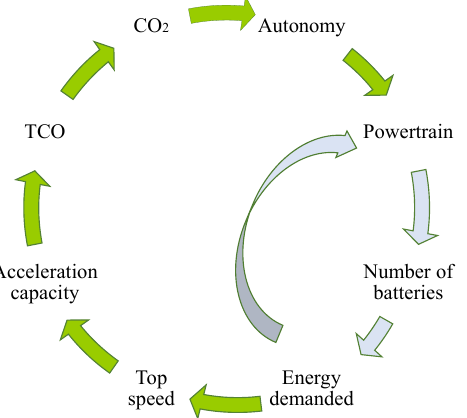
Figure 5. Illustration of the multi-objective optimization process to obtain the best powertrain configuration for a given application and given autonomy.